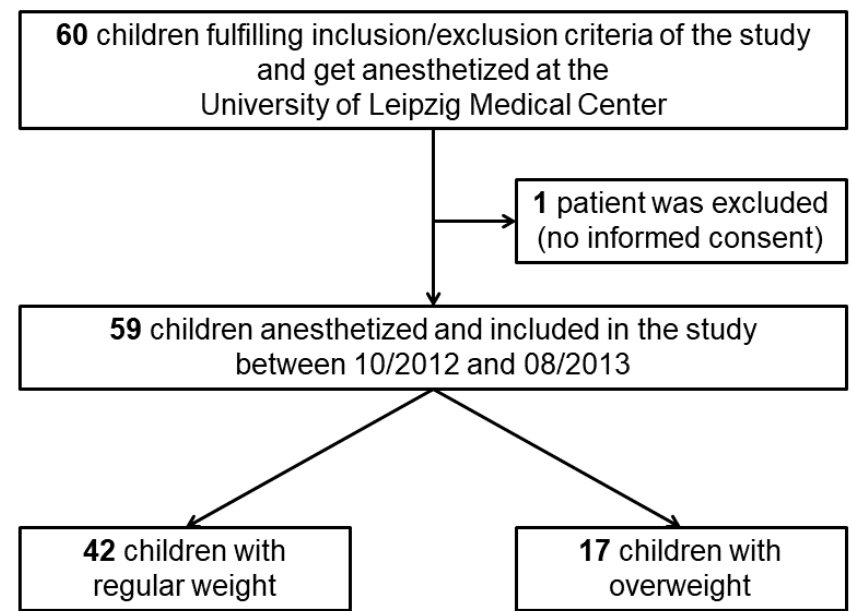
Figure 1. Flowchart of study enrollment.